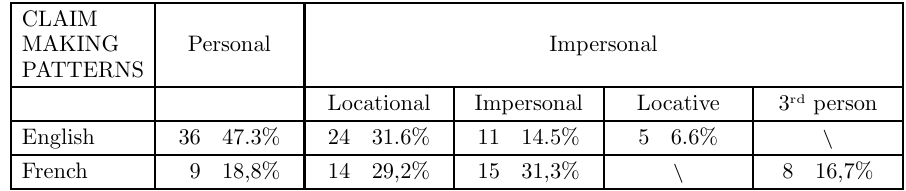
CLAIM MAKING Personal Impersonal PATTERNS